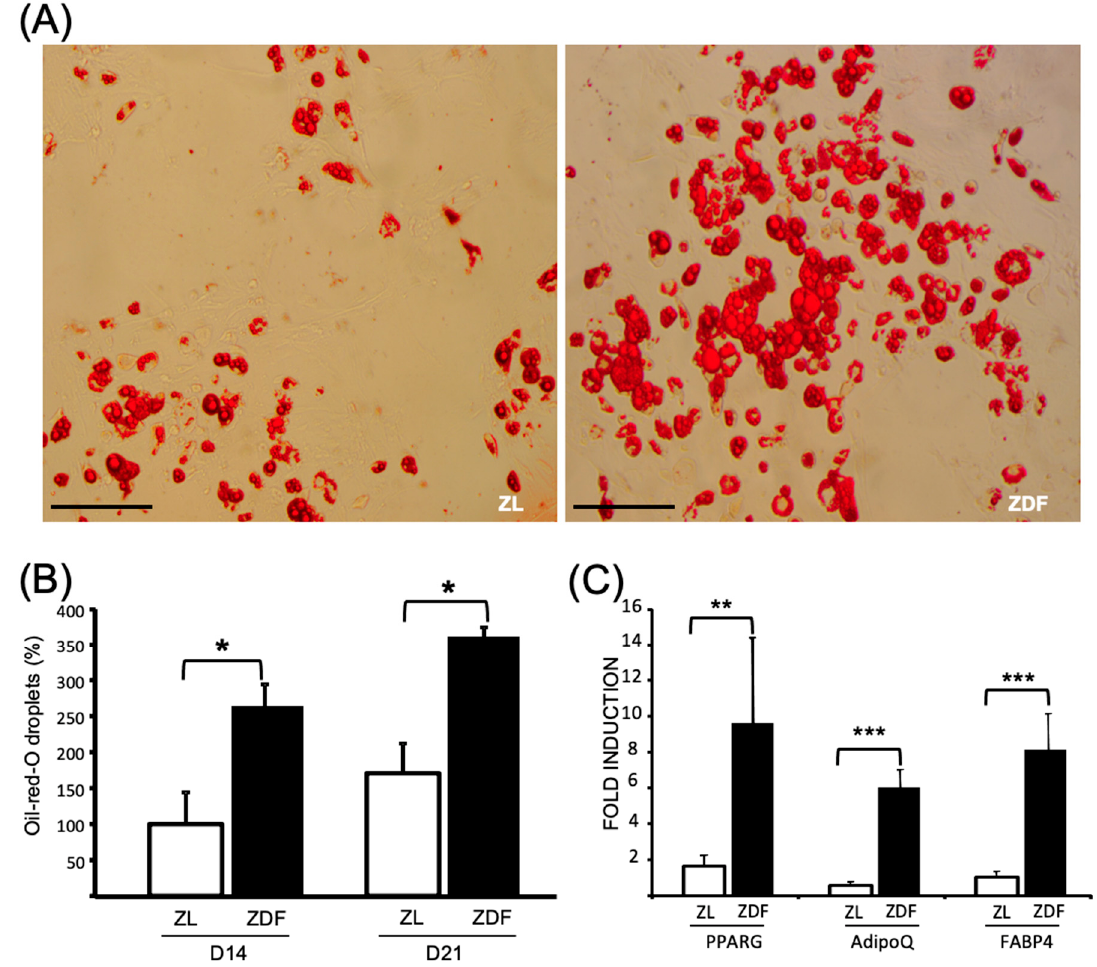
Figure 3. Enhanced adipogenic differentiation of the ZDF-BMMSCs. ( A ) Representative light microphotograph of BMMSCs from ZDF and ZL rats cultured in adipogenic-induction medium for 21 days, Scale bar = 200 μ m. ( B ) Oil red-O droplets in BMMSCs after 14 and 21 days of culture measured by spectrophotometer, ( C ) Expression levels of the Pparg , AdipoQ , and Fabp4 genes in the BMMSCs measured by qRT-PCR at day 14. Values are mean ± SEM. The data are from 3 independent wells per condition in 3 independent experiments (n = 9). * P < 0.05; ** P < 0.01; *** P < 0.001.